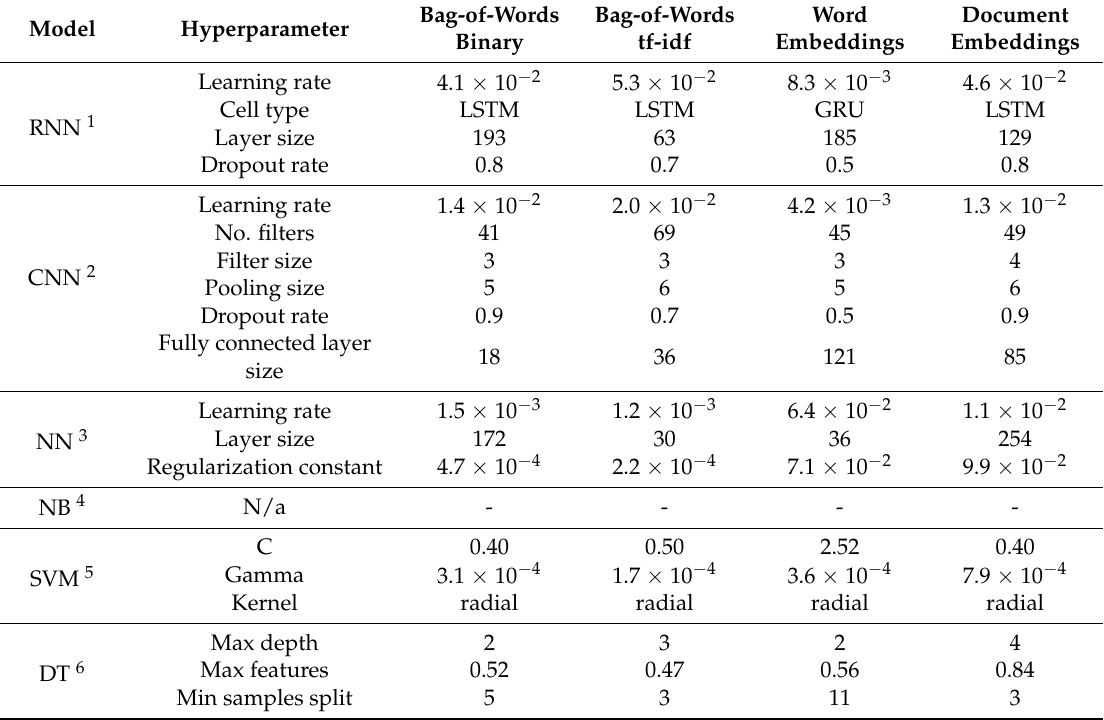
Table A1. An overview of the optimal hyperparameters for each combination of a text representation and a classification